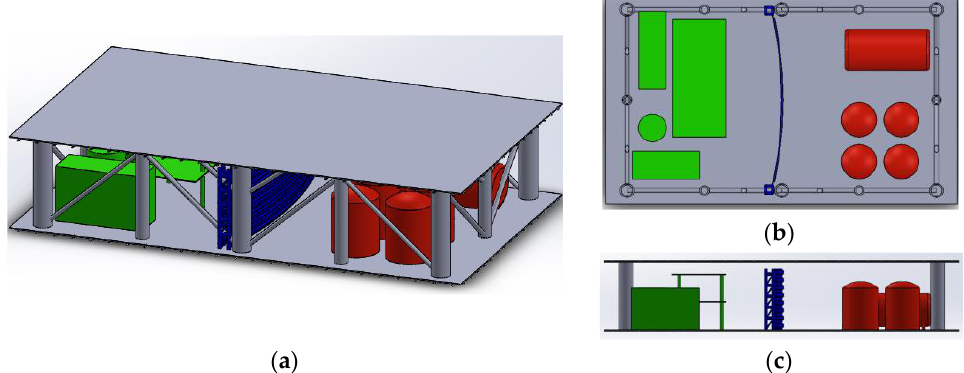
Figure 24. Diagram of the blast walls on offshore platform. ( a ) overall view; ( b ) top view; and ( c ) front view.